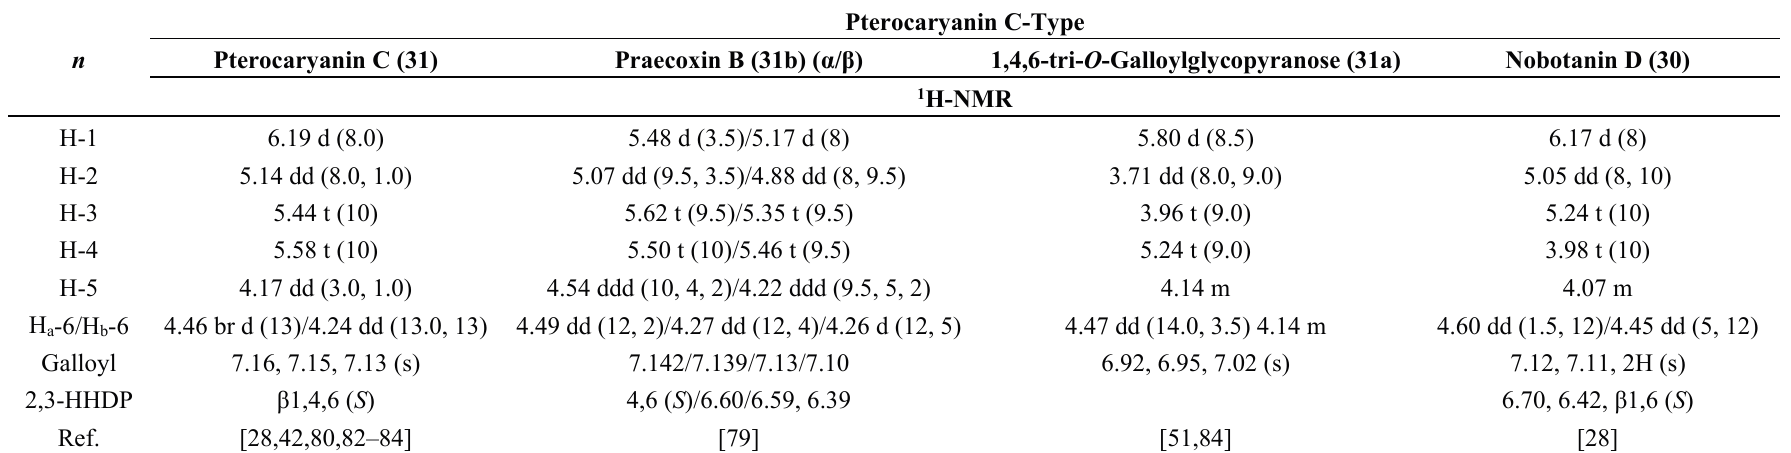
Table 1. 1 H-NMR of sugar moieties of pterocaryanin C-type monomeric ellagitannins.